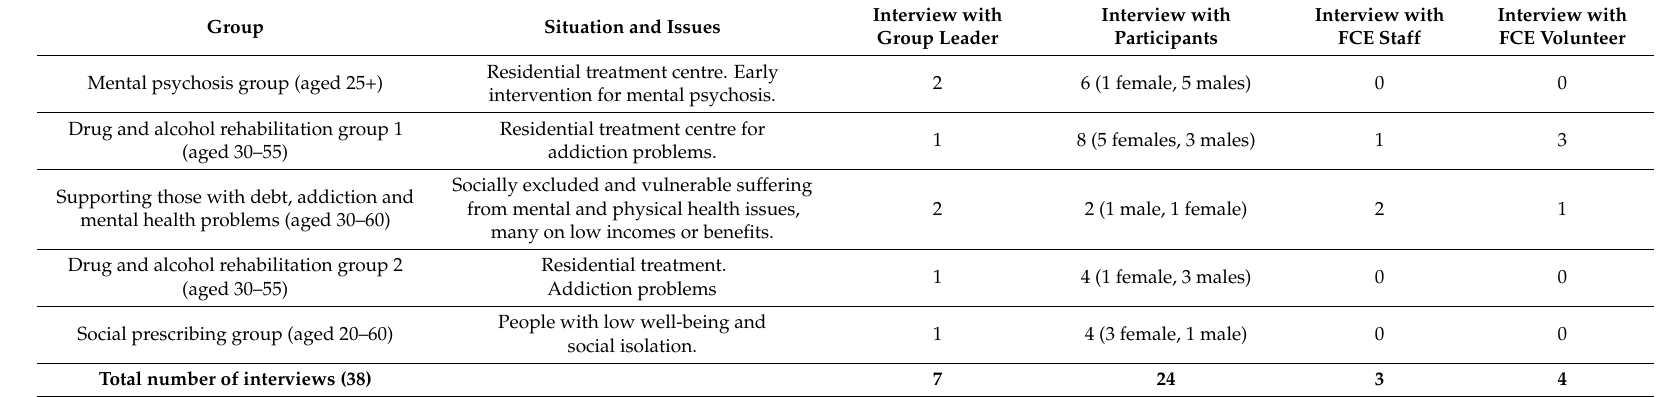
Table 3. The five adults groups involved in the research. FCE = Forestry Commission